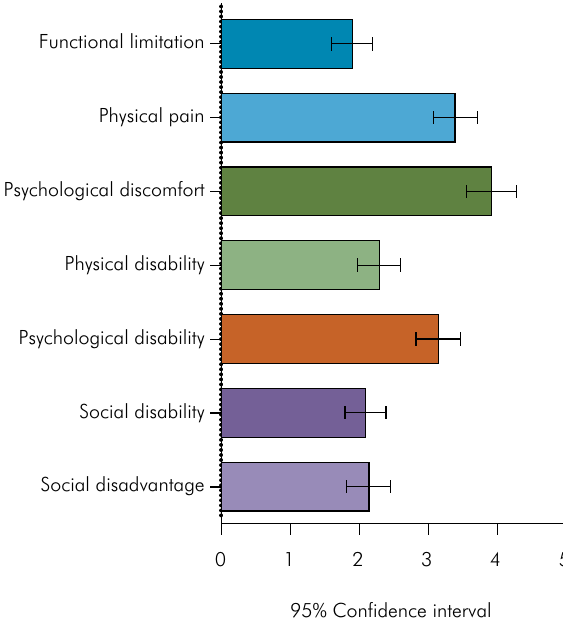
Figure 2. Mean and 95% confidence interval of OHIP-14 scores per domains (n =